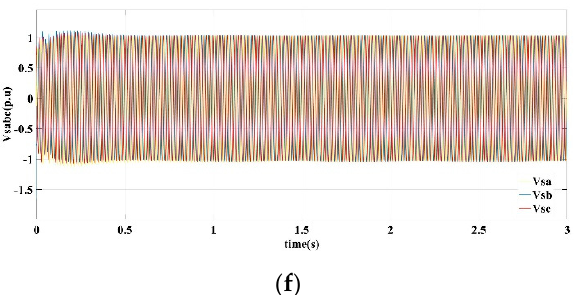
Figure 5. Fault ‐ tolerant control response curves in scenario I. ( a ) Current error estimation of d ‐ axis and q ‐ axis, ( b ) Voltage error estimation of d ‐ axis and q ‐ axis, ( c ) d ‐ axis and q ‐ axis current output, ( d ) d ‐ axis and q ‐ axis voltage output, ( e ) Frequency output, ( f ) Three ‐ phase voltage output. Figure 5a is the learning observer estimation curve of the detection current error of the d ‐ axis and the q ‐ axis. Figure 5b is the learning observer estimation curve of the meas ‐ ured voltage error of the d ‐ axis and the q ‐ axis. Figure 5c shows the output current response curve of the d ‐ axis and q ‐ axis. Figure 5d is the output voltage response curve of d ‐ axis and q ‐ axis. Figure 5e is the frequency response curve. Figure 5f shows the three ‐ phase voltage output of the DG.